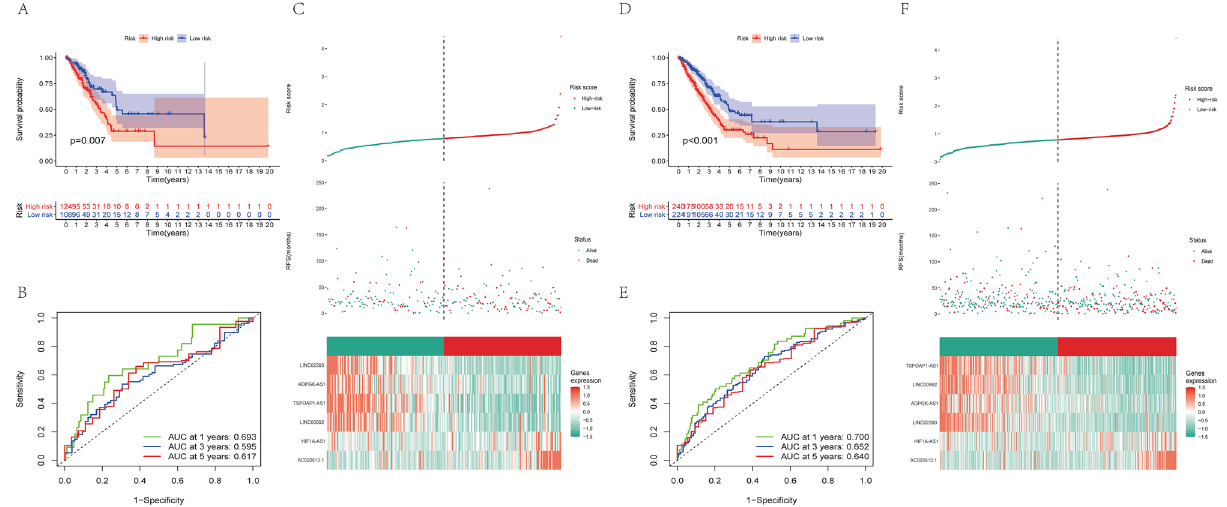
Figure 5. The prognostic value of the risk model of the six IClncRNAs in the TCGA testing and entire cohorts. ( A ) Kaplan–Meier survival curves of OS of patients in the high- and low-risk groups for the testing cohort. ( B ) The time ‐ dependent ROC analyses of this model in the testing cohort. ( C ) The distribution of risk scores based on the IClncRNAs, vital statuses of patients sorted by risk score and the six-lncRNA expression heatmap in the testing cohort. ( D ) Kaplan–Meier survival curves of OS of patients in the high- and low-risk groups for the entire cohort. ( E ) The time ‐ dependent ROC analyses of this model in the entire cohort. ( F ) The distribution of risk scores based on the IClncRNAs, vital statuses of patients sorted by risk score and the six-lncRNA expression heatmap in the entire cohort.